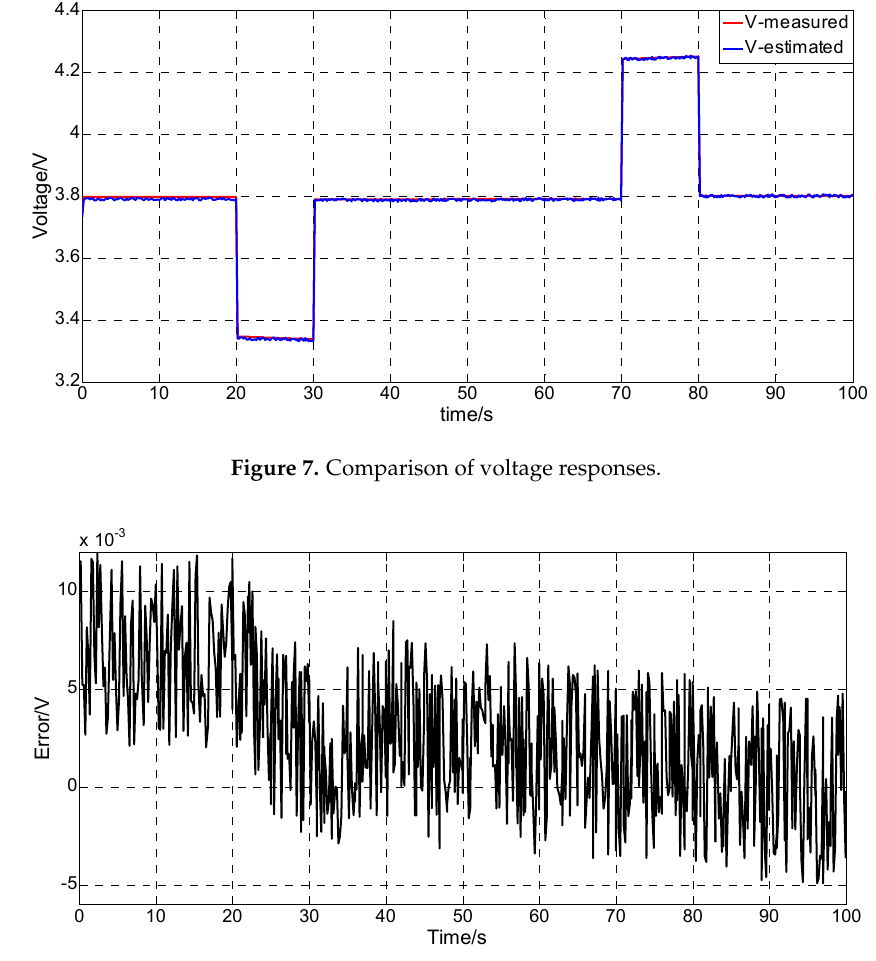
Figure 8. Differences between measured and estimated voltages.